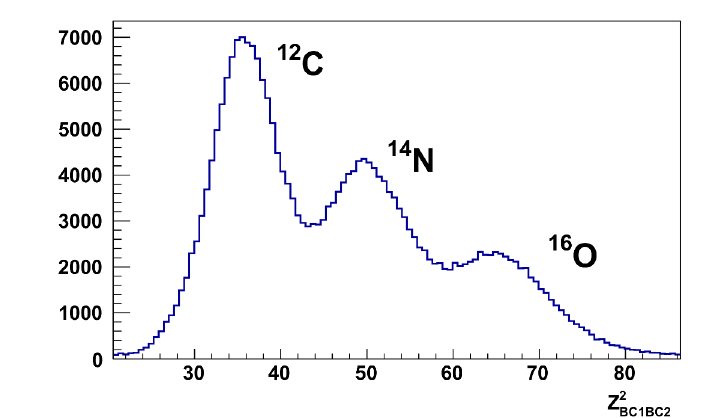
Figure 2. The square of the beam particle charge before the beam-target interaction